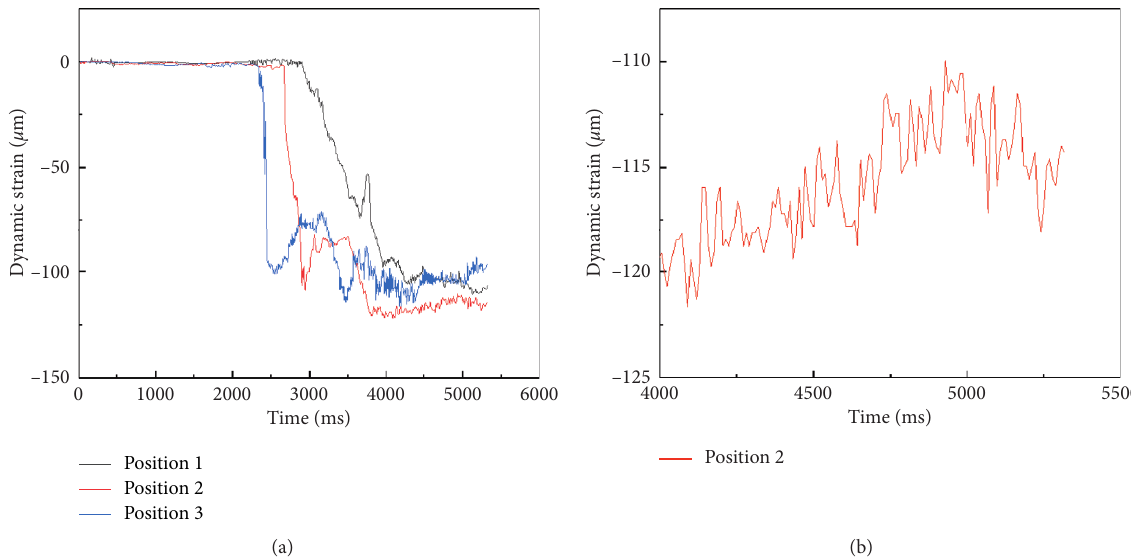
Figure 5: Dynamic strain curve on the back of the grade-A ship steel sample. (a) Dynamic strain obtained by three detection points. (b) Partial enlarged view of strain gauge 2 that recorded the dynamic strain.